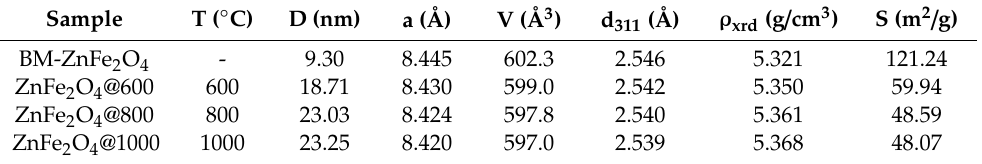
Table 1. The structural properties of ZnFe 2 O 4 nanoparticles, annealed at different temperatures (T).